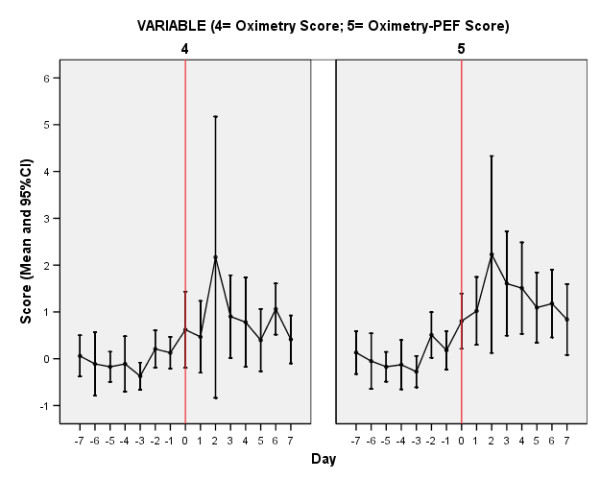
Time Course of Oximetry and Oximetry-PEF Scores At Exacerbation. Time course of Oximetry and Oximetry-PEF scores from seven days prior (-7) to exacerbation onset (day 0, vertical line) and seven days into exacerbation of COPD. Data represent the mean and 95%CI for each score separately.